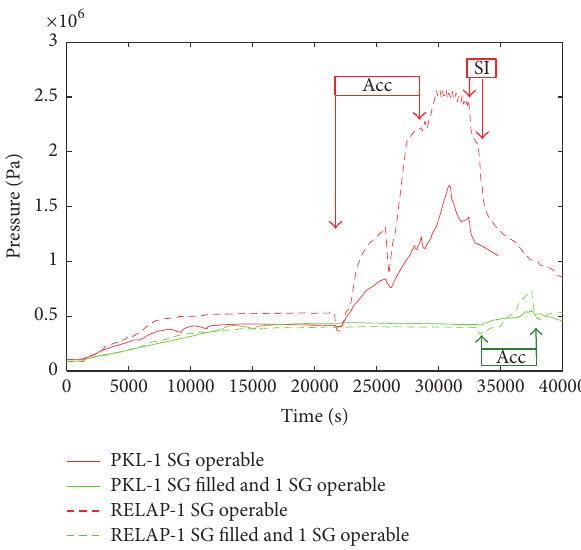
Figure 15: Primary pressure. PKL versus RELAP5. Steam generators influence. Injections.